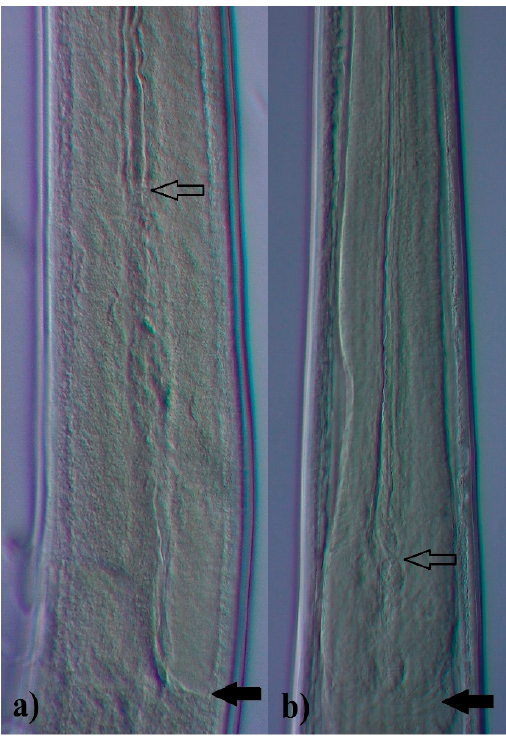
Figure 1. Esophageal-intestinal (EI) valve of ( a ) Ostertagia leptospicularis from roe deer ( Capreolus capreolus ), ( b ) Ostertagia ostertagi from cattle ( Bos taurus ; arrows at anterior and posterior end; magnification 600×).